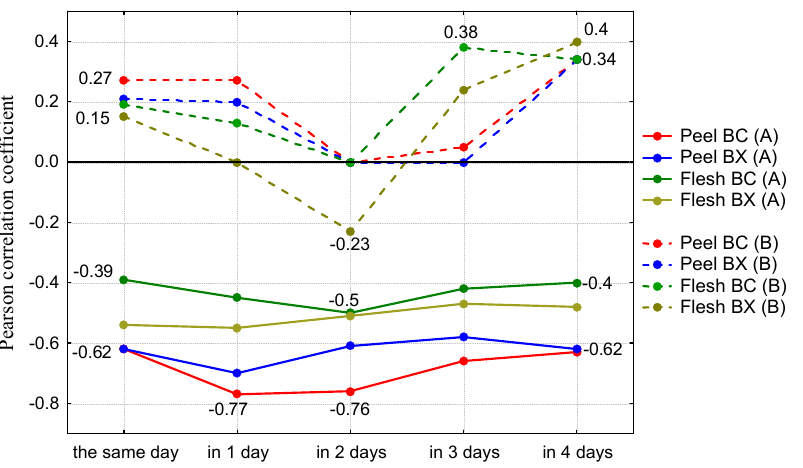
Figure 9. Dynamics of the interplay between betalains in red-colored table beet accessions (groups 1 and 2) and abiotic factors (A—the correlation with air temperature; B—the correlation with precipitation).